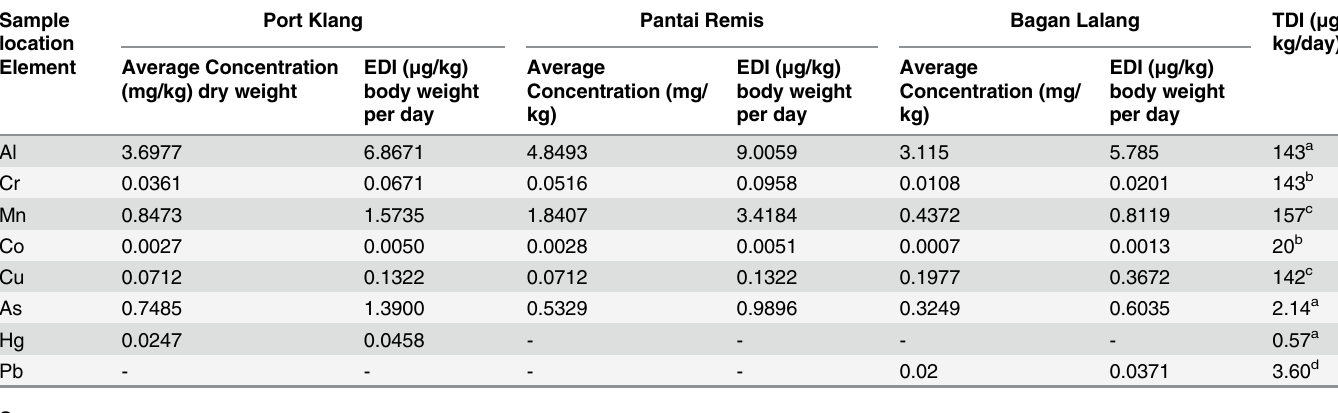
Table 6. Estimated daily intake ( EDI ) of heavy metals through consumption of fish.